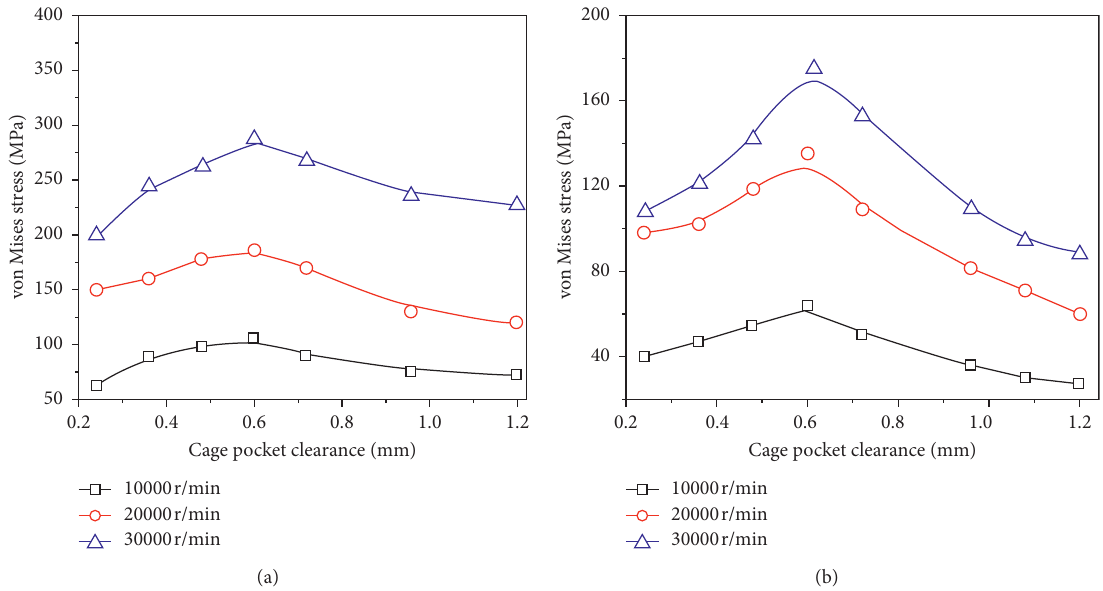
Figure 13: Influence of cage pocket circumferential clearance on cage stress at the stage of start-up and stop. (a) Cage stress at the stage of start-up. (b) Cage stress at the stage of